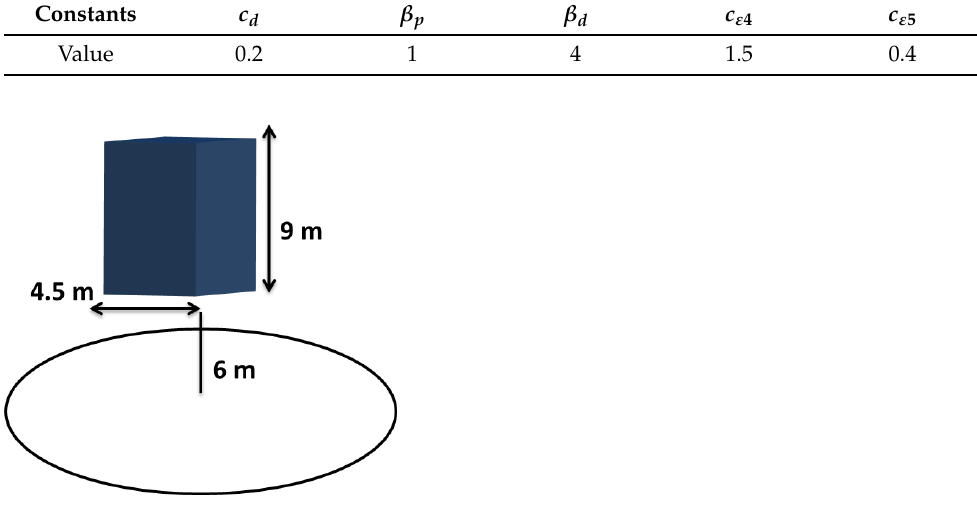
Figure 4. Schematic of the trees implemented in the CAD model. Table 2. Constant parameters for estimation of the tree height and crown